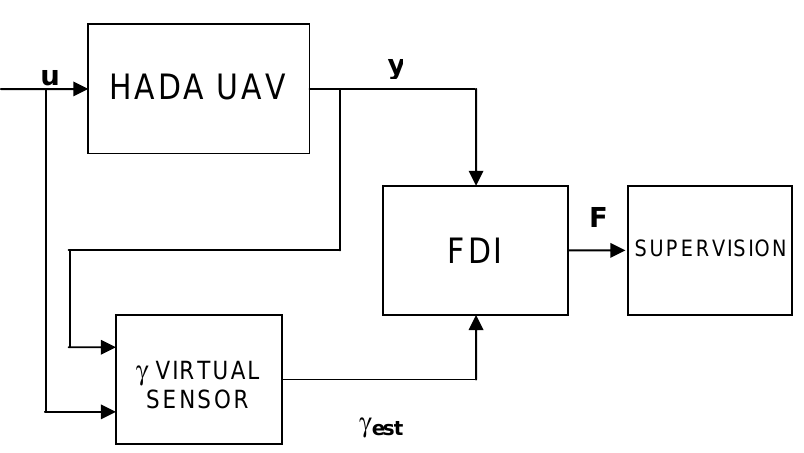
Figure 3. Virtual sensor based